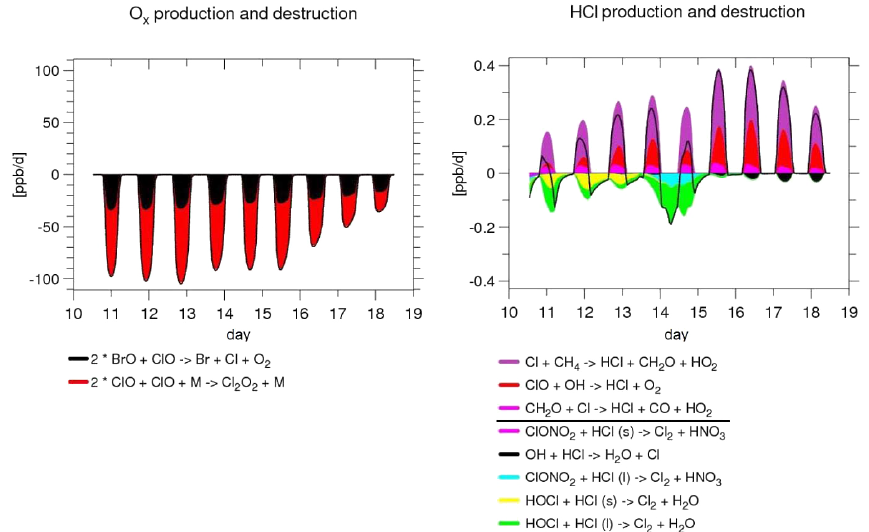
Figure 7. Left panel: O 3 depletion rates due to ClO–BrO (black) and ClO–ClO (red) catalytic cycles. Right panel: HCl production and depletion rates due to the set of reactions listed at the bottom of the panel. Simulations have been carried out on the 400K isentropic